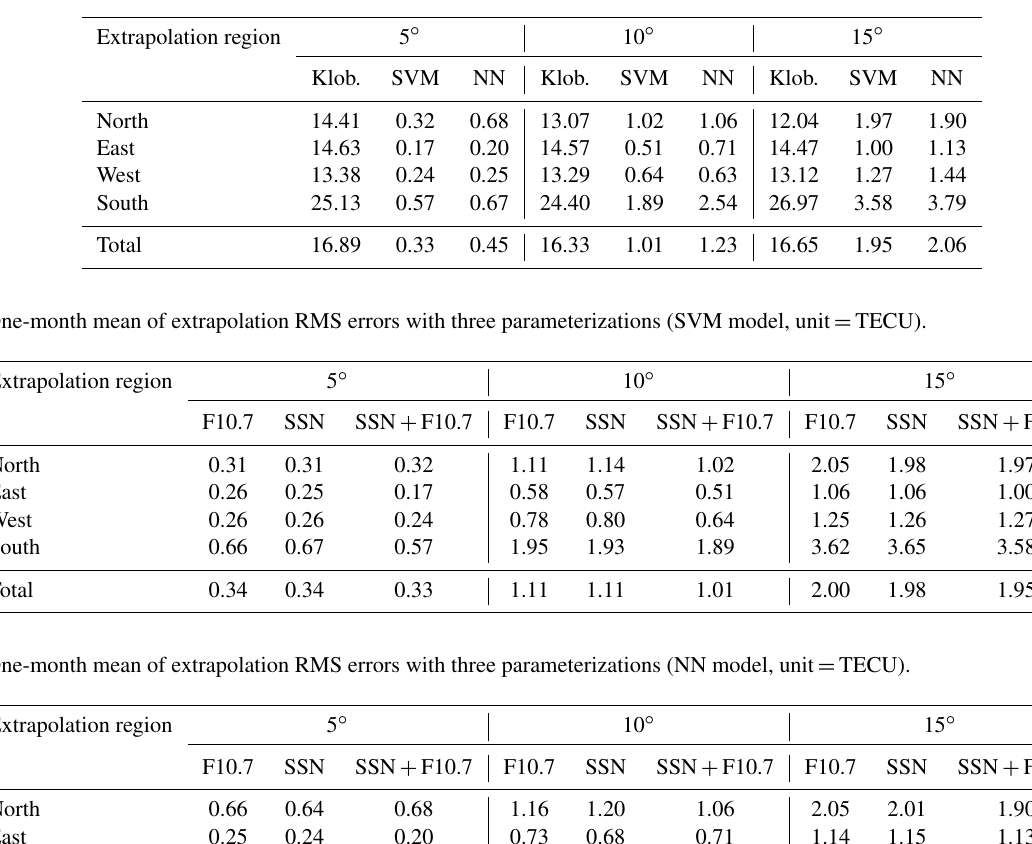
Table 2. One-month mean of extrapolation RMS errors using the SVM, NN, and Klobuchar models (unit = TECU). Extrapolation region 5 ◦ 10 ◦ 15 ◦ Klob. SVM NN Klob. SVM NN Klob. SVM NN North 14.41